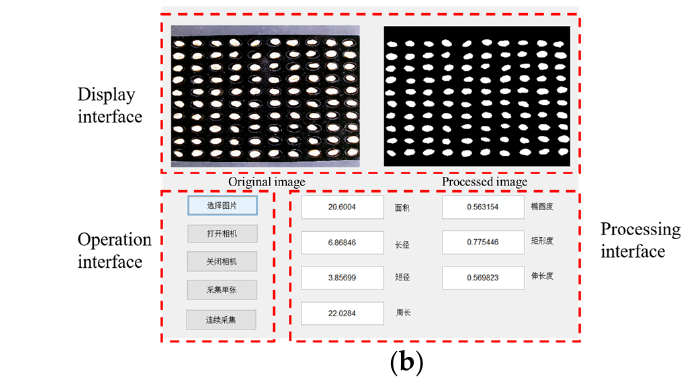
Figure 2. Software platform architecture ( a ) and interface ( b ).